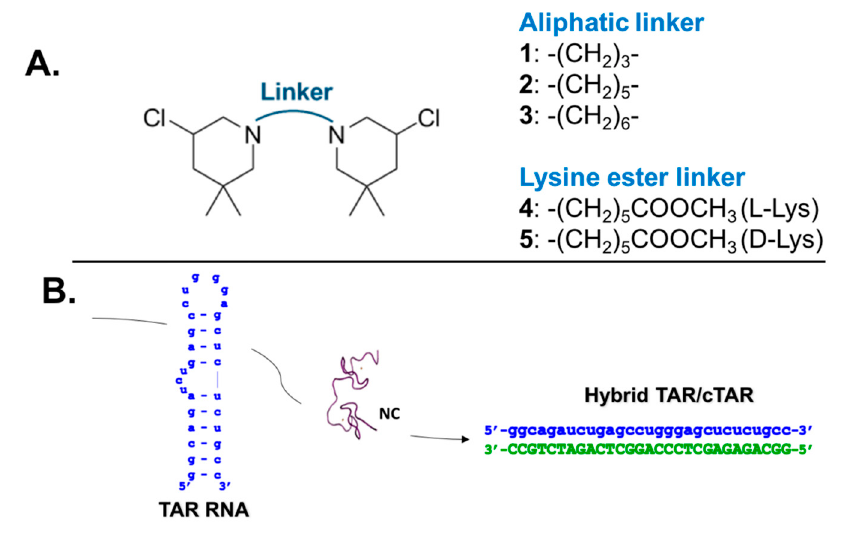
Figure 1. ( A ) Chemical structure of bis-3-chloropiperidines analyzed in this work. ( B ) Sequence and secondary structure of construct replicating TAR RNA which was employed in our assays. NC chap- erone activities on TAR RNA led to the formation of the hybrid